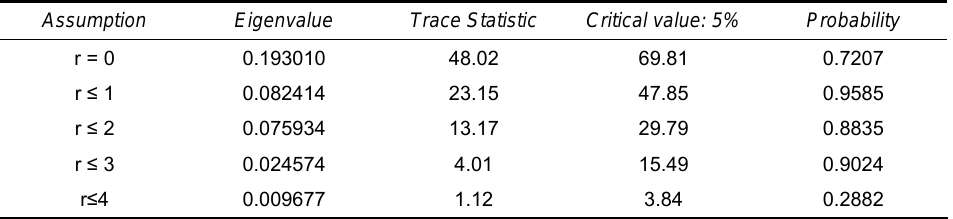
Table 2. Cointegration test: trace test